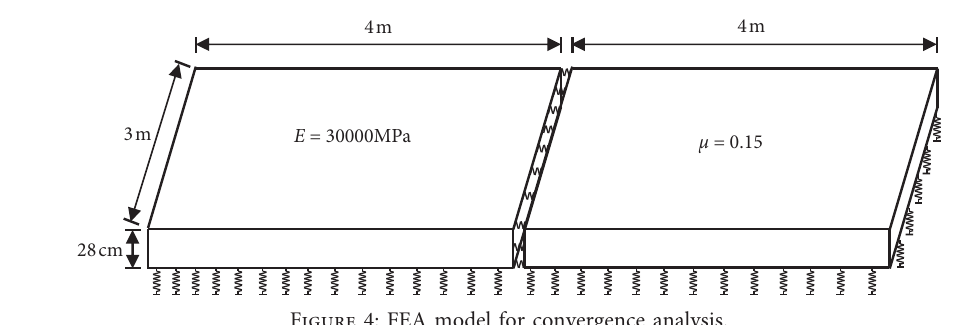
Figure 4: FEA model for convergence analysis.